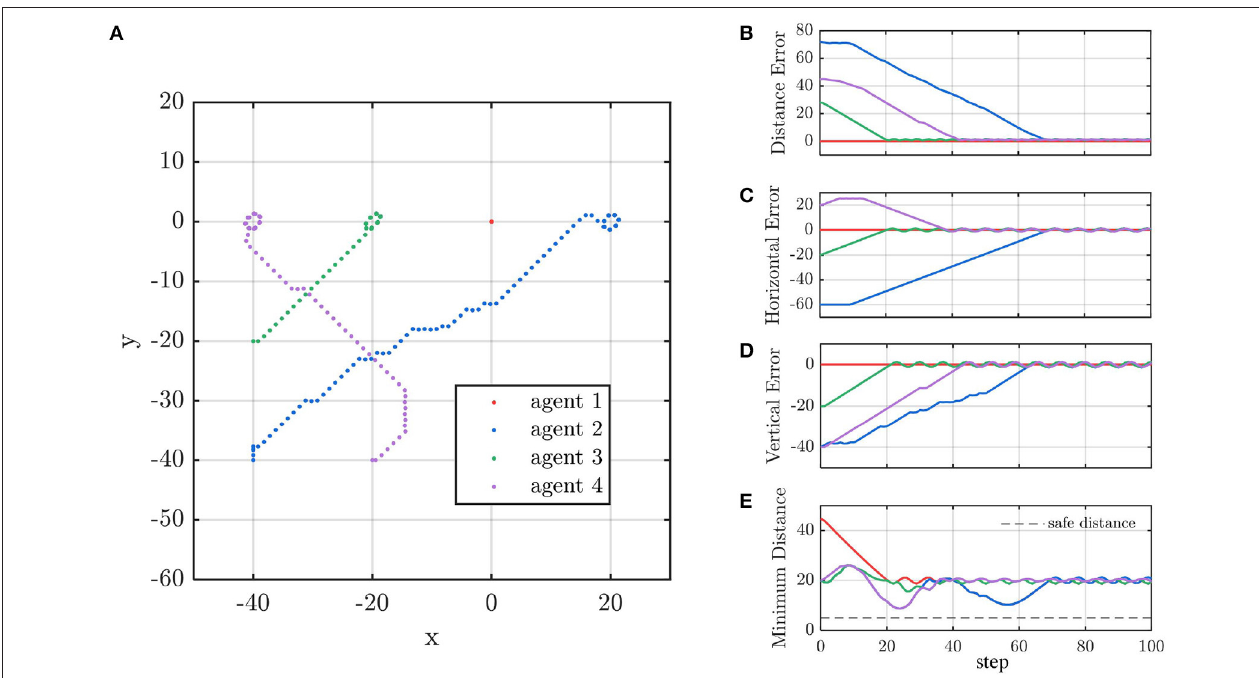
FIGURE 13 | (A) The agent’s trajectory. (B–D) The agent’s distance to destination and (E) the distance between